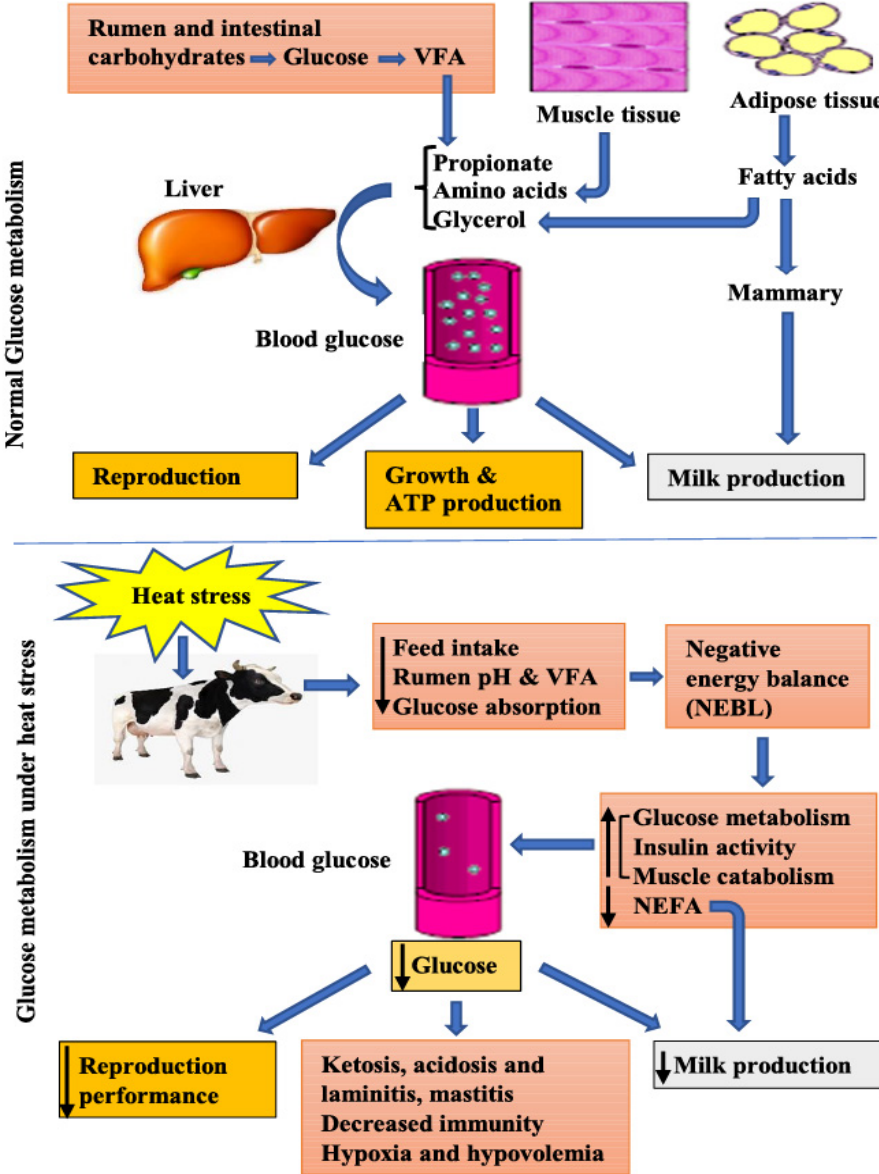
Figure 1. Glucose metabolism under normal and heat-stressed conditions in cattle.